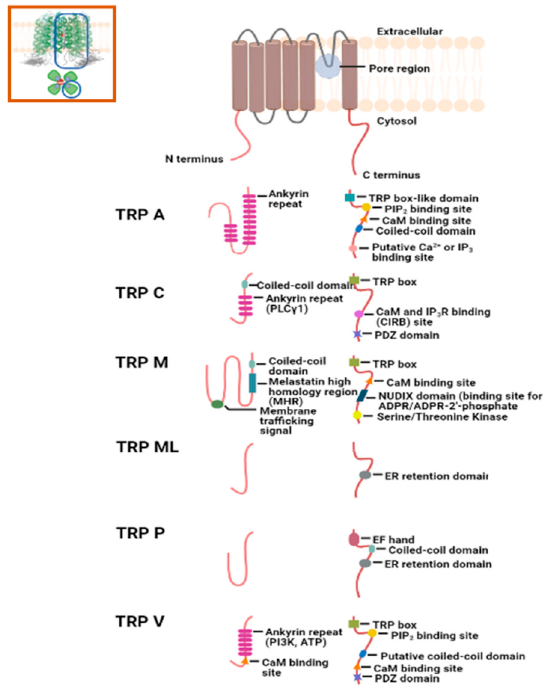
Figure 5. Structure of TRP channel isoforms. The general topology of a TRP channel includes a homo- or hetero-tetrameric formation (see inset). The basic structure of each subunit consists of cytosolic N- and C-termini, and six transmembrane domains with the pore region between TM 5–6. A variable number of ankyrin repeats on the N-terminus are found in TRP A, TRP C, and TRP V. No specific interaction site or functional domain has been identified so far on the N-terminus of TRP ML and TRP P. The most common domains found on the C-terminus across TRP isoforms are TRP box, coiled-coiled domain, and calmodulin (CaM) binding site [59–62]. ADPR, adenosine diphosphate ribose; CIRB, calmodulin and IP 3 R binding site; NUDIX, nucleoside diphosphate-linked moiety X; PI3K, phosphoinositide 3-kinase; PIP 2 , Phosphatidylinositol 4,5-bisphosphate; PLC γ , phospholipase C